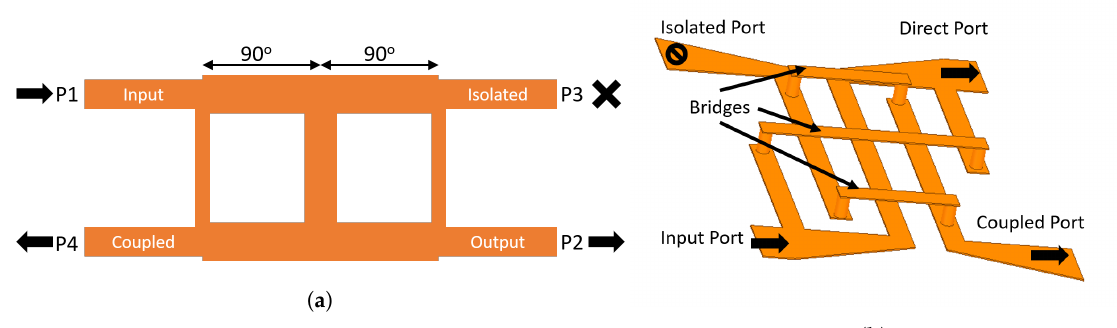
Figure 5. Traditional implementations of directional cross couplers: ( a ) multi-section branch line cross-coupler; and ( b ) Lange directional coupler.